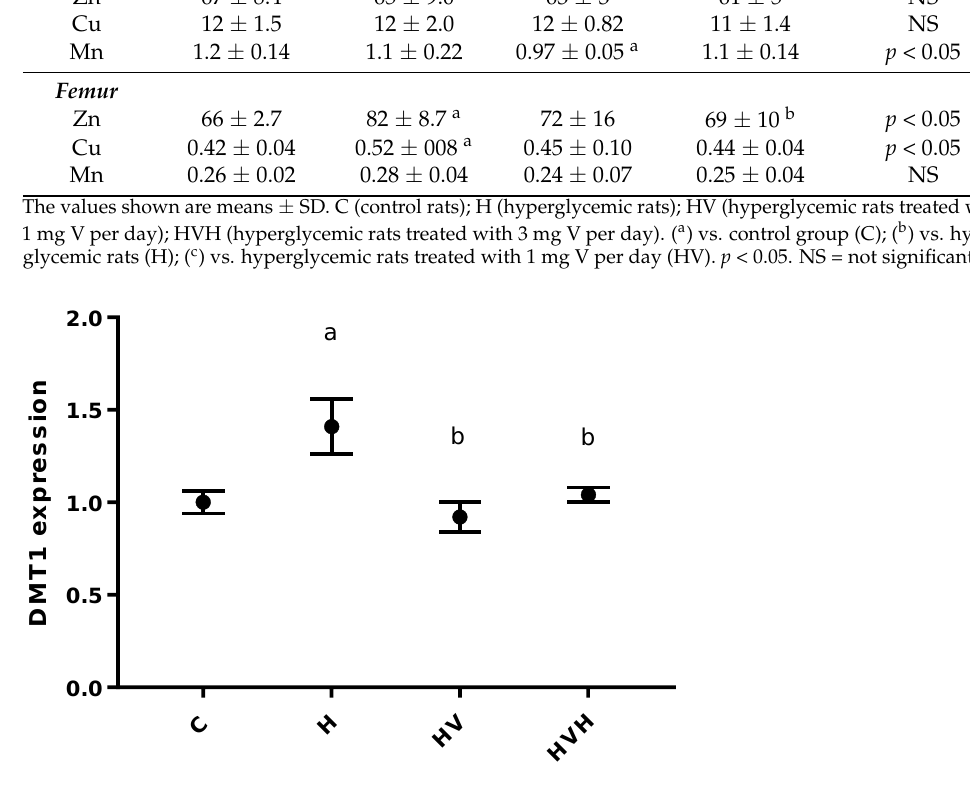
Figure 2. Changes in DMT1 expression in kidney tissue. p < 0.05. C (control rats); H (hyperglycemic rats); HV (hyperglycemic rats treated with 1 mg V per day); HVH (hyperglycemic rats treated with 3 mg V per day). (a) vs. control; (b) vs. H. p <